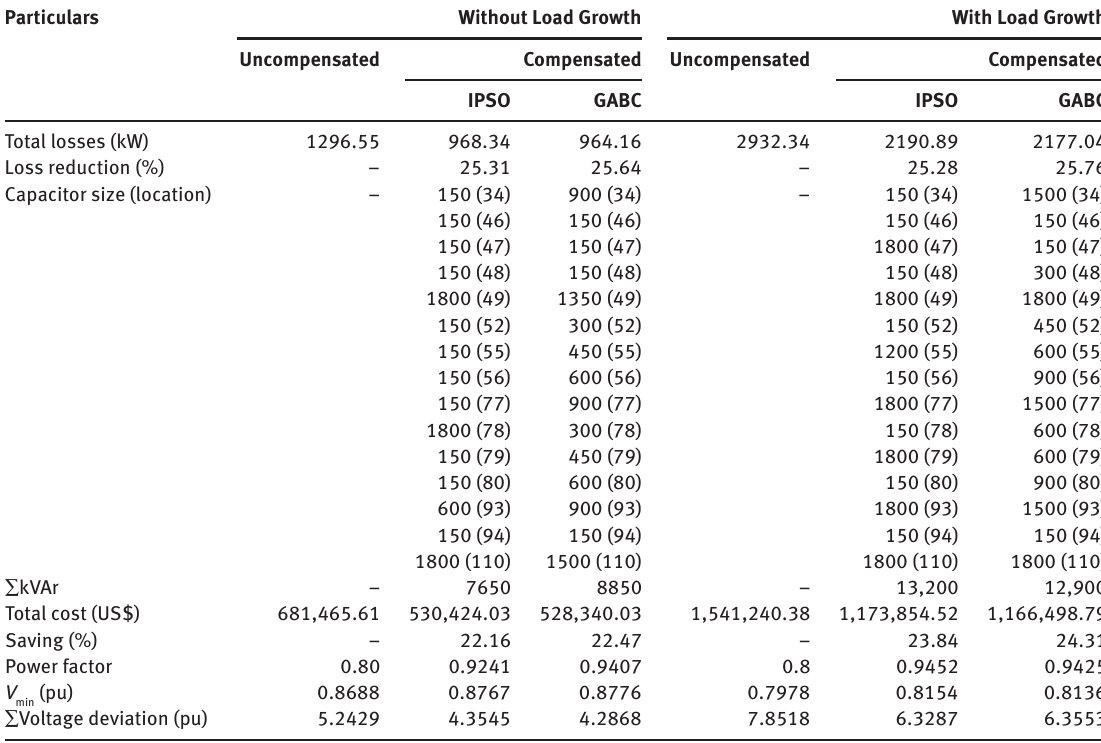
Table 13: Simulation Results of the 118-Bus Distribution Network after SC Placement Using the IVM